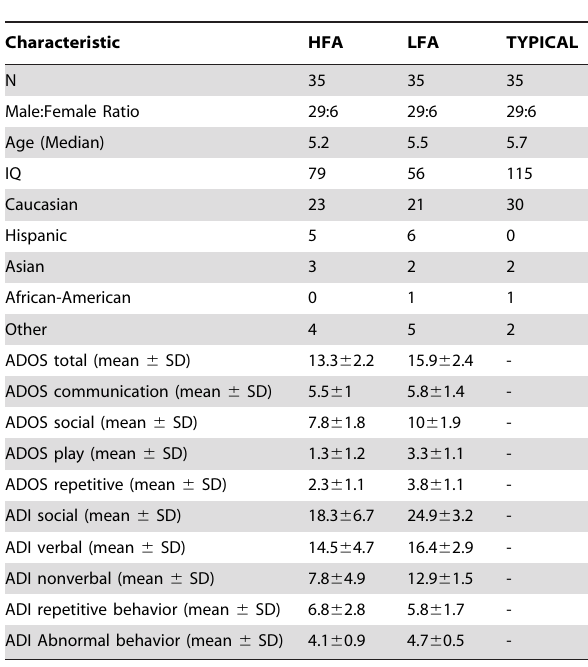
Table 1. Demographic Variables for the three groups of subjects evaluated in this